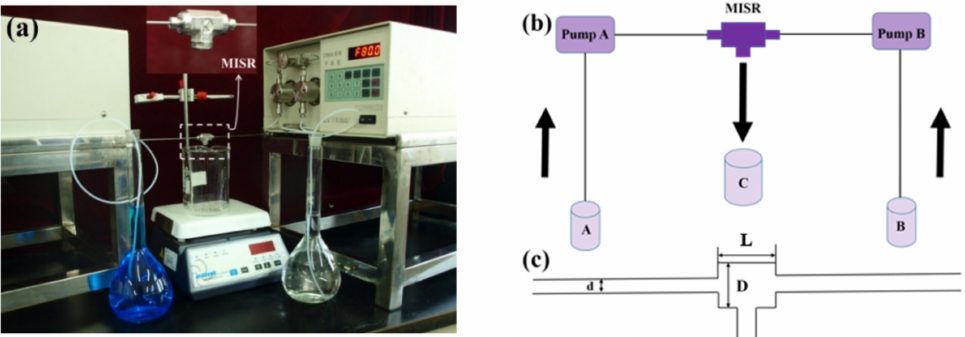
Figure 1. ( a ) MISR experimental system; ( b ) operation flow chart of MISR (A, B, and C are precursor containers and product collector, respectively); ( c ) internal structure of the T-joint (geometric details: inner diameter of the feed pipes d = 0.6 mm, length of the T-joint L = 2 mm, inner diameter of the T-joint D = 1.8